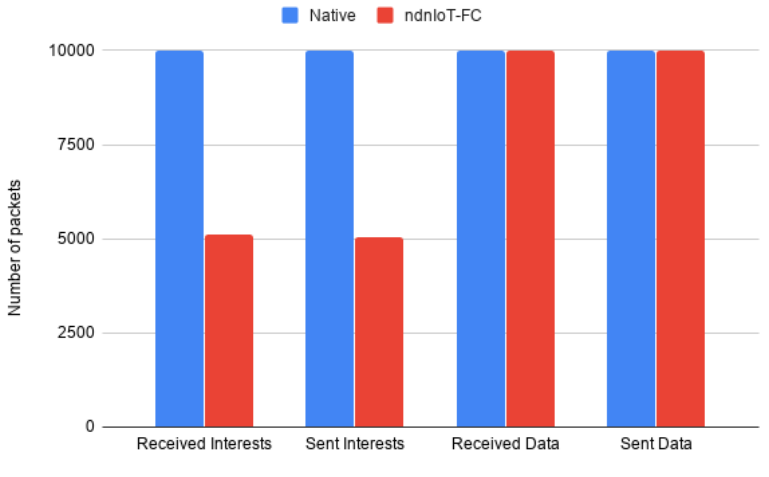
Figure 13. Use case 3—Network overhead metrics.